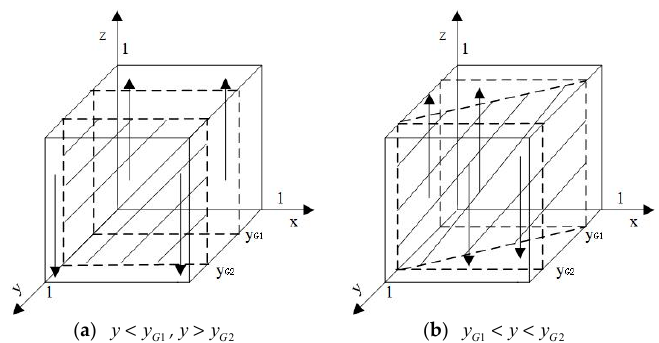
Figure 3. Evolutionary path of governments’ strategy.